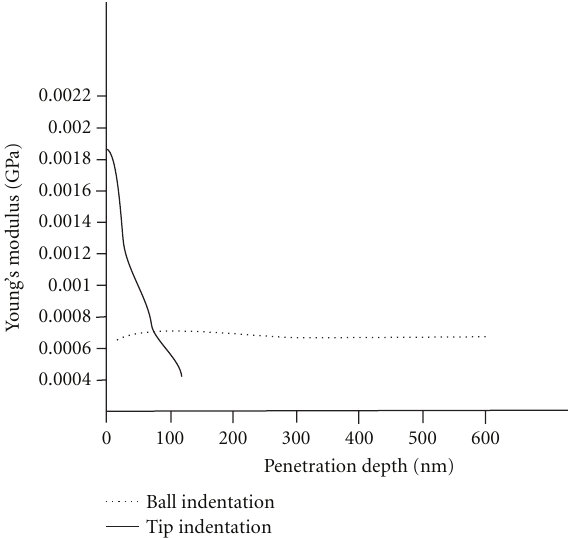
Figure 7: Young’s modulus versus penetration depth of AFM tip for cartilage sliced in di ff erent